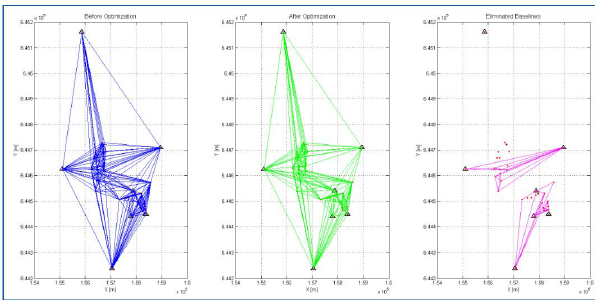
Figure 2: SOOM of precision and sensitive to detect 5 mm displace- ment. The panels from left to right illustrate the original network before optimisation, optimised one and removed baselines, respec-